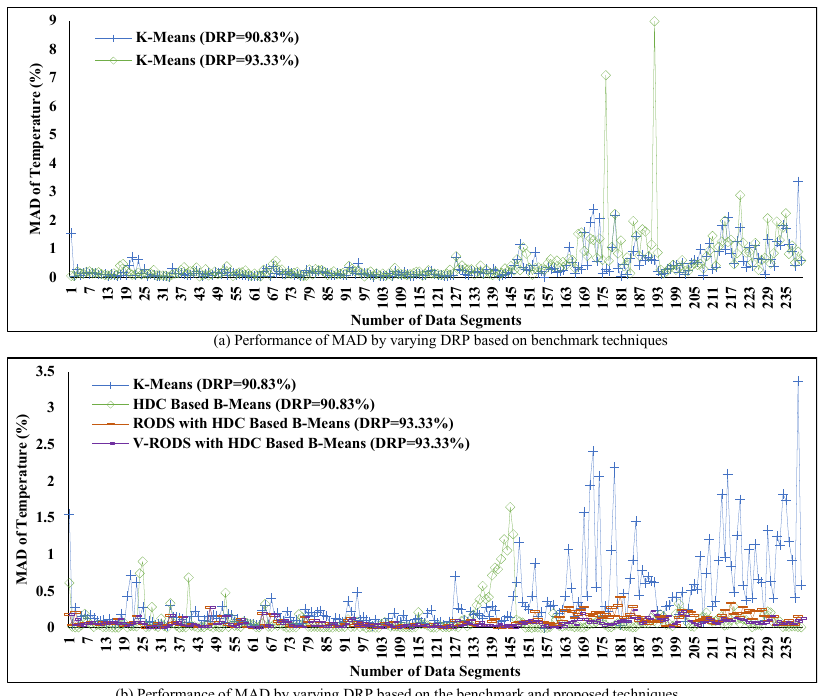
Figure 19. A comparison between the conventional and proposed techniques in terms of MAD and DRP versus the number of data segments. ( a ) MAD versus data reduction percentage (DRP) of the conventional techniques; ( b ) MAD versus DRP of the conventional and the proposed